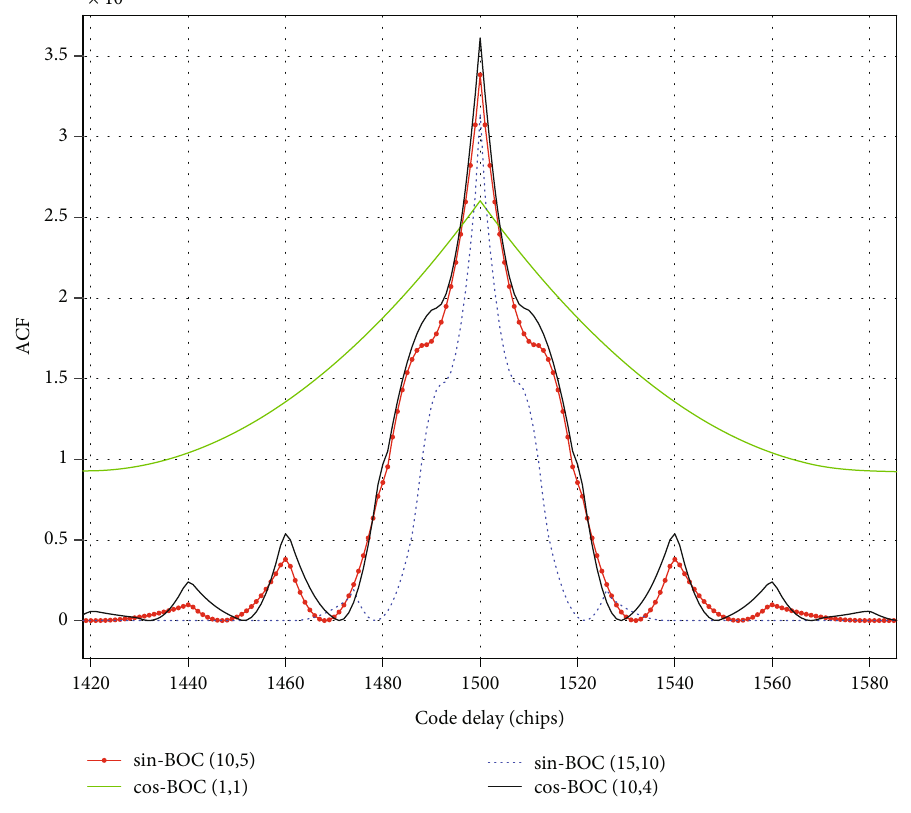
Figure 14: ACF of the four BOC signals.